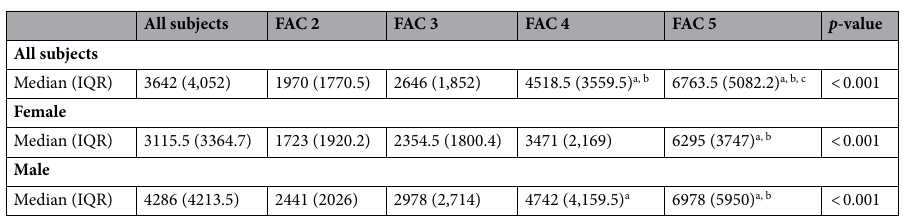
Table 2. Daily number of steps in each ambulation category. FAC; Functional Ambulation Category, IQR; interquartile range. The Kruskal–Wallis test was used to investigate the differences among FAC. The significance between each FAC by the Steel–Dwass test are shown as follows; a significant difference vs. FAC